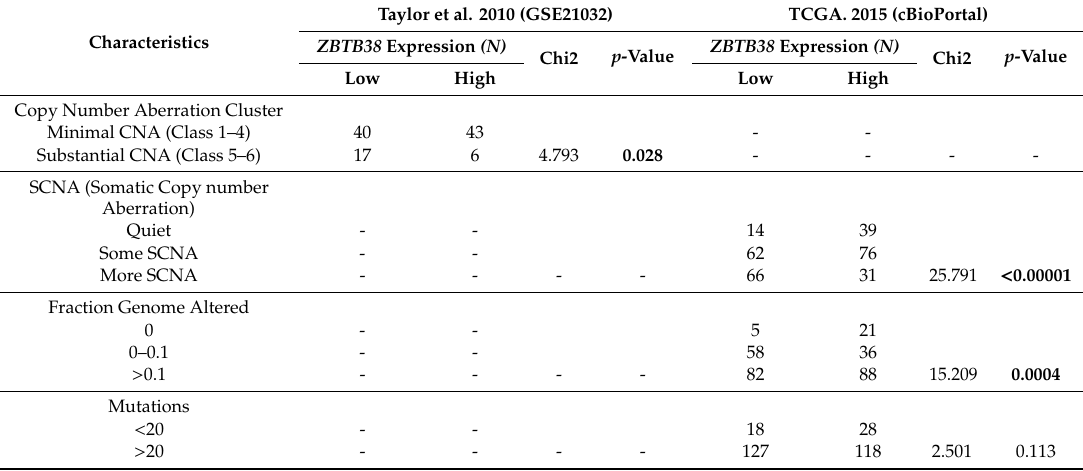
Table 4. ZBTB38 levels and chromosomal instability in localised prostate